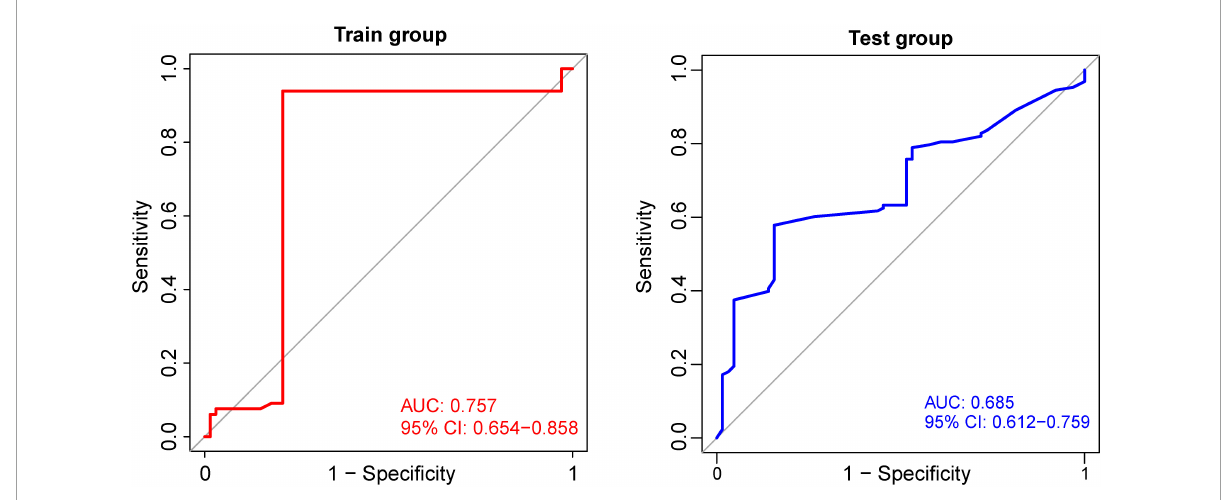
FIGURE5 Receiver operating characteristic curves for the artificial neural network. The AUC curve of GSE19738 training cohort is on the left, and the AUC curve of GSE98793 testing cohort is on the